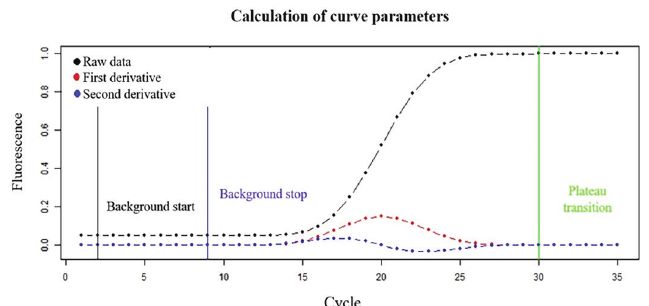
Figure 1 - Amplification based on a sigmoid model with 4 parameters and calculated threshold cycles based on a derivative nonlinear model as well as the efficiency of amplification. First derivative – red line, second derivative – blue line, amplification graph – black